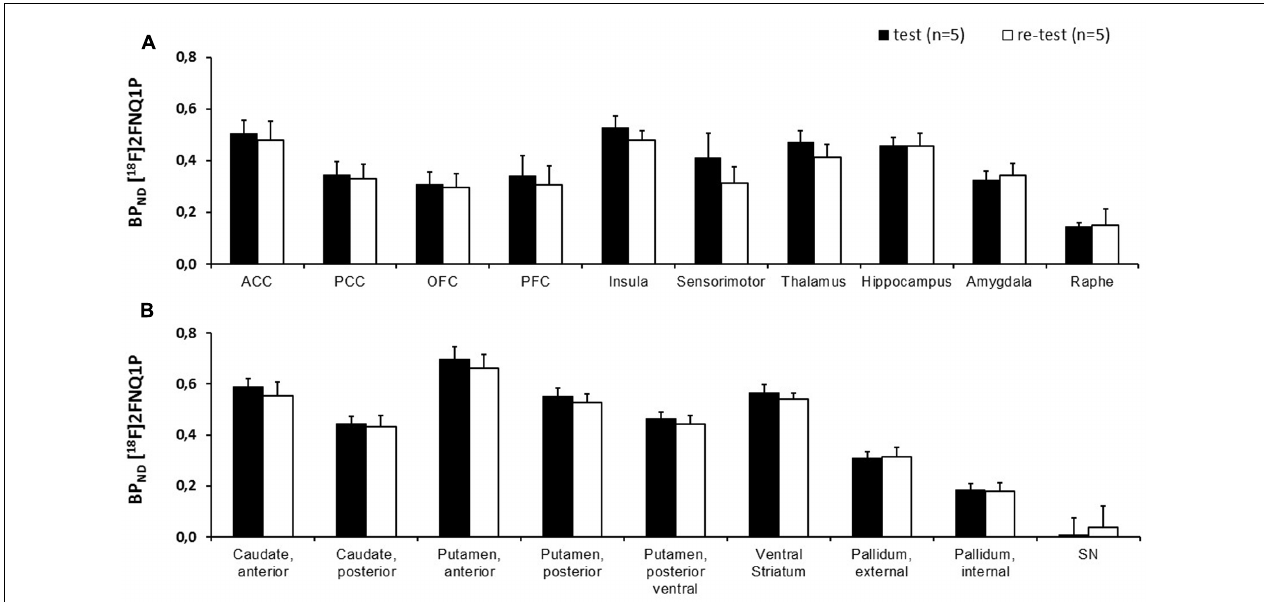
FIGURE 3 | Comparison of BP ND between test and retest scans. Histogram representing the BP ND of [ 18 F]2FNQ1P averaged over five subjects for test and retest scans in (A) neocortex and other areas and (B) basal ganglia. No significant difference between test and retest BP ND was found on paired t -test with Bonferroni correction for multiple comparisons. Abbreviations: ACC, anterior cingulated cortex; PCC, posterior cingulated cortex; OFC, orbitofrontal cortex; PFC, prefrontal